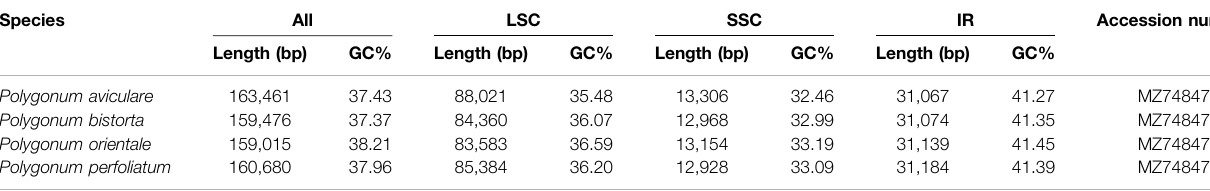
TABLE 1 | Chloroplast genome features of Polygonum . Species